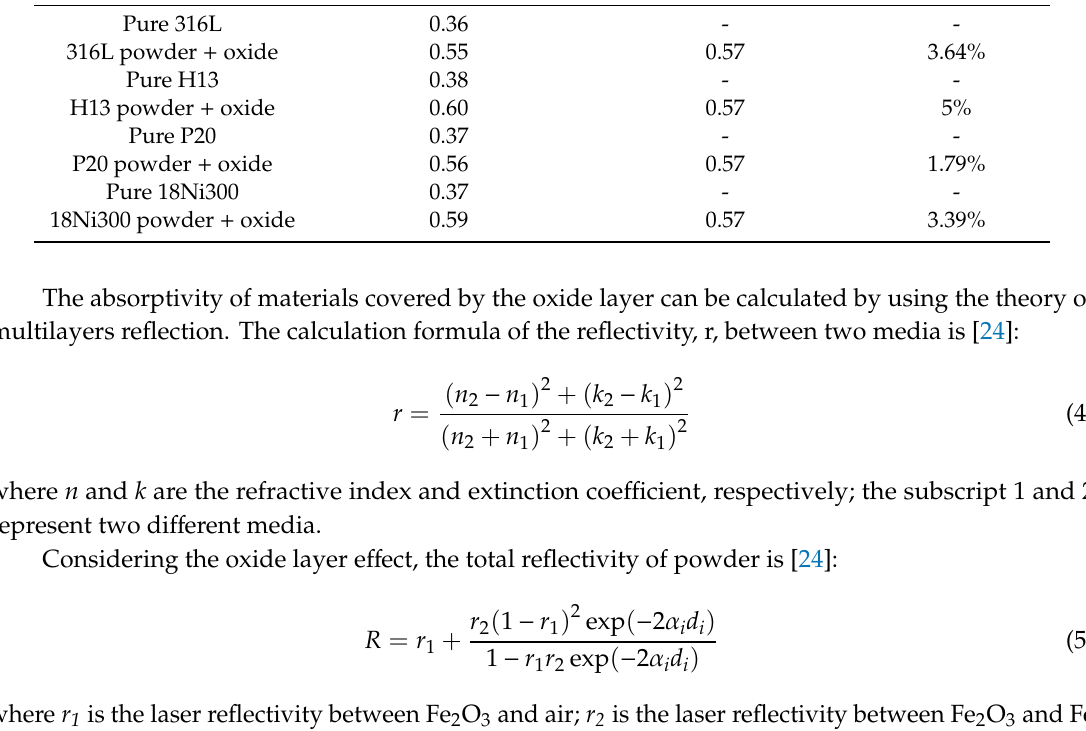
Table 4. The absorptivity of powders without and with considering the e ff ect of oxide layer. Material Measured Absorptivity Calculated Absorptivity Di ff